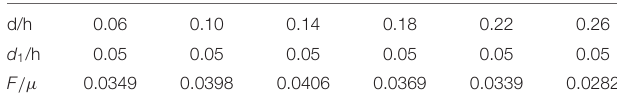
TABLE 3 | Minimum value of F /µ for working